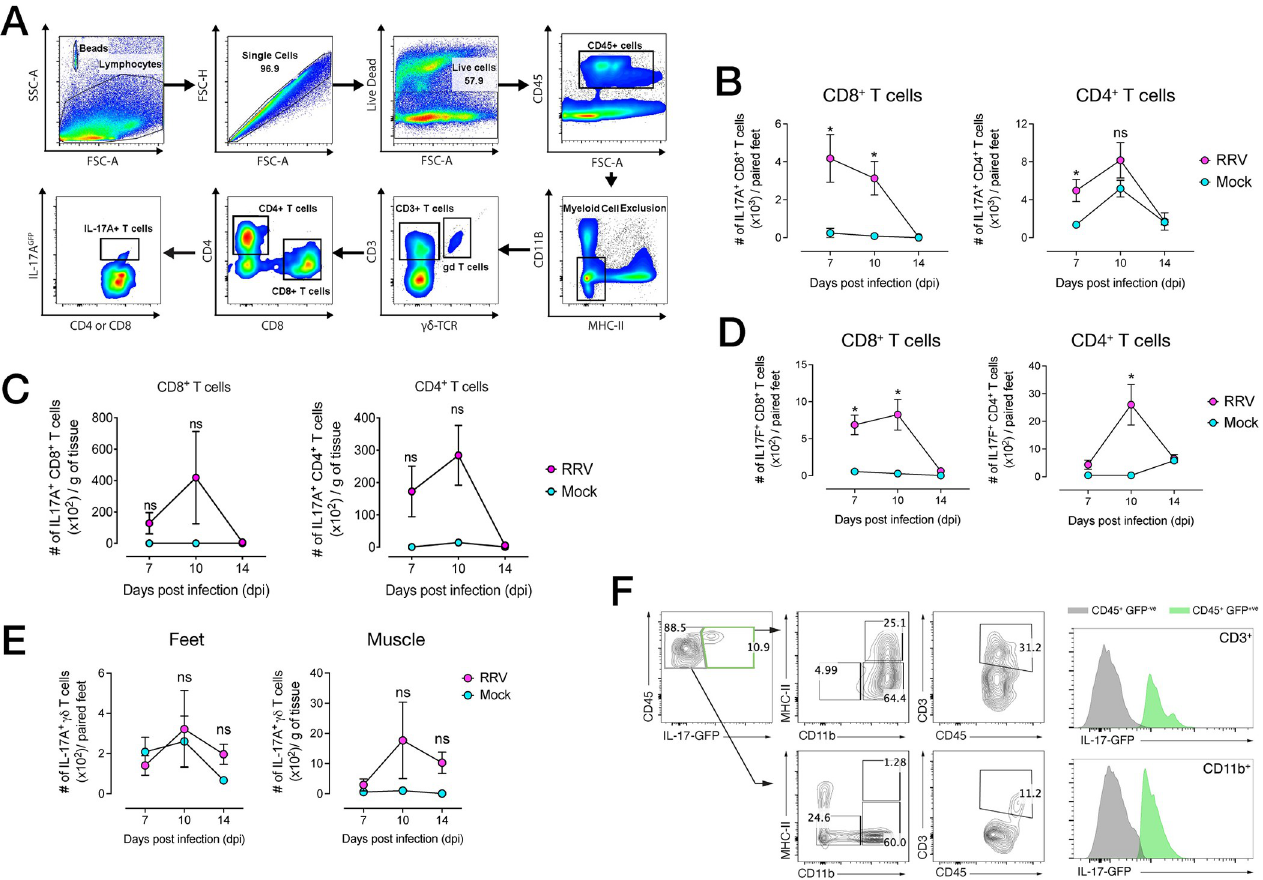
Fig 3. IL-17–producing cells infiltrate musculoskeletal tissues in RRV disease. A) Gating strategy used to quantify infiltrating cells in the feet in RRV- infected IL-17 GFP mice. Live singlet cells were gated for CD45 + and subsequently excluded from the CD11b + MHC-II + myeloid lineage (Lin) gate. CD3 + cell and subsequent CD4 + and CD8 + cell populations gated on IL-17A + (or IL-17F + ), and γδ TCR-positive T cells ( γδ T cells) were gated from the CD3 + γδ TCR + cell population. B ) IL-17-expressing CD8 + and CD4 + T cells in the feet and C) quadriceps muscle of RRV-infected IL-17 GFP mice at 7, 10, 14 and 30 dpi. Data shown (mean +/- SEM) as number of LIVE CD45 + Lin - CD3 + CD8 + IL-17A GFP+ or LIVE CD45 + Lin - CD3 + CD4 + IL-17A GFP+ T cells, per paired feet or per gram of muscle tissue. D) IL-17F + CD8 + and CD4 + T cells in the feet of RRV-infected IL-17 GFP mice at 7, 10 and 14 dpi. Data shown (mean +/- SEM) as number of LIVE CD45 + Lin - CD3 + CD8 + IL-17F + or LIVE CD45 + Lin - CD3 + CD4 + IL-17F + T cells, per paired feet. E) IL-17A + γδ T cells in the feet (left) and quadriceps muscle (right) of RRV-infected IL-17 GFP mice at 7, 10 and 14 dpi. Data shown (mean +/- SEM) as number of LIVE CD45 + Lin - CD3 + CD4 - CD8 - γδ TCR + T cells, per paired feet, or per gram of muscle tissue. IL-17F expression were assessed by intracellular cytokine staining. Data in B-E representative of 3 independent experiments (n = 5 mice per group) and statistically significant differences between groups for each time point determined by Mann-Whitney U Test. � , p < 0.05; �� , p < 0.01; ns: not significant. F) Flow cytometry gating strategy for IL-17 GFP+ CD45 + cells and corresponding histogram (normalized counts from concatenated samples) for IL-17 GFP reporter expression in CD3 + T cells and CD11b + myeloid cells in the joints of RRV-infected mice, at 10 dpi. Populations gated from GFP -ve (grey histogram) and GFP +ve (green histogram). Mean population frequencies shown in gates. Data representative of 3 independent experiments (n = 5 mice per group).